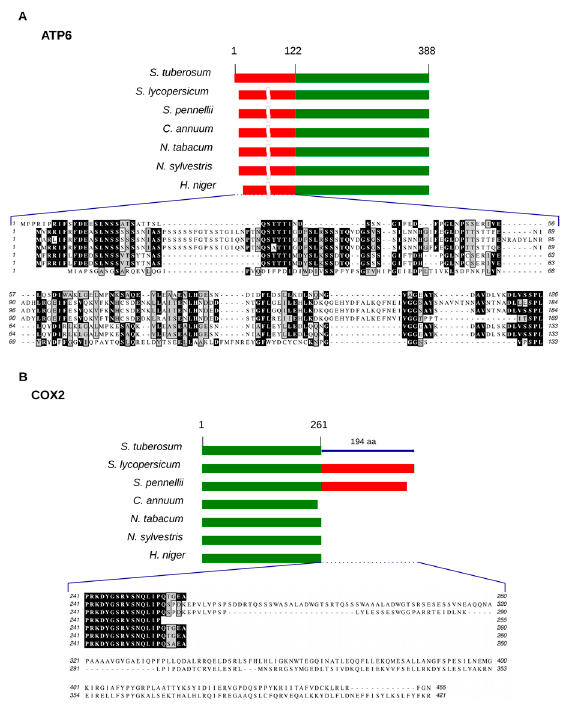
Figure 4. Representative examples of variable mitochondrial protein sequences in Solanaceae species. The primary structures of S. tuberosum ATP6 ( A ) and COX2 ( B ) proteins were compared with those of other Solanaceae species available in GenBank. (A) Red and green bars indicate non-conserved or conserved aa sequences in ATP6, respectively. (B) Cultivated ( S. lycopersicum ) and wild ( S. pennellii ) tomato have additional 194 aa at the C-terminus of the protein compared with potato and other Solanaceae species. The numbers above red and green bars indicate the start and end positions of potato mitochondrial proteins.